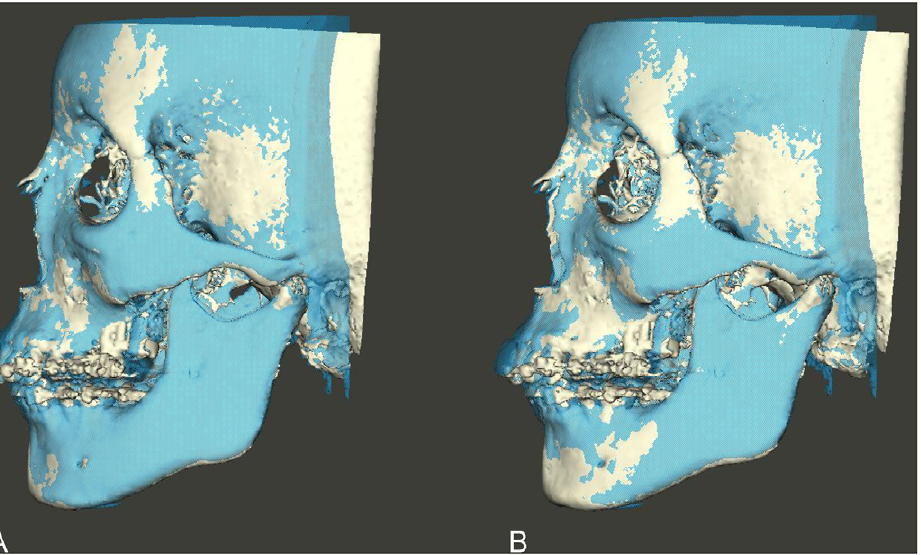
Figure 4. Transparency overlay of superimposed 3D CBCT models. Left side view. (A) models registered on the anterior cranial base. (B) same models registered on the left zygomatic arch.